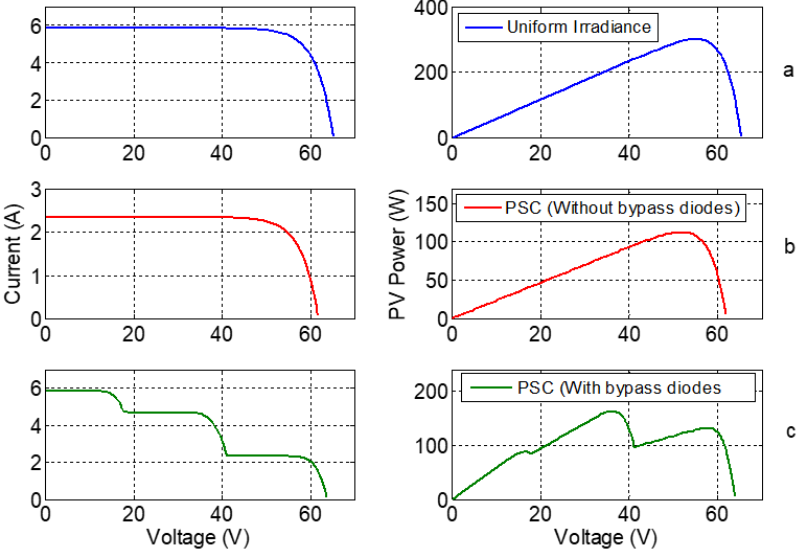
Figure 1. Current-voltage (I-V) and power-voltage (P-V) curves of a module ( a ) Uniform irradiance; ( b ) partial shading condition (PSC) without bypass diodes; and, ( c ) PSC with bypass diodes.